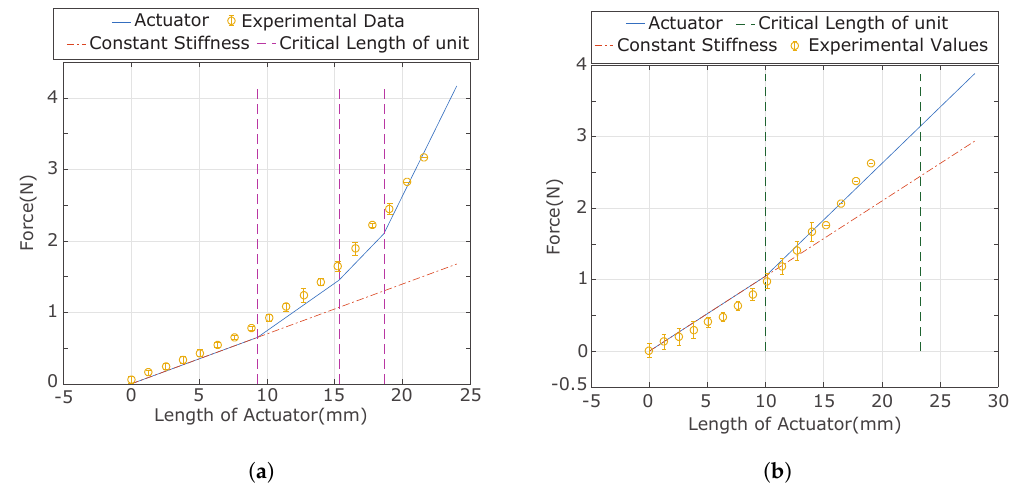
Figure 17. Length dependent hardening: ( a ) experimental hardening vs. theoretical hardening— Pattern: 4013; and ( b ) experimental hardening vs. theoretical hardening—Pattern: